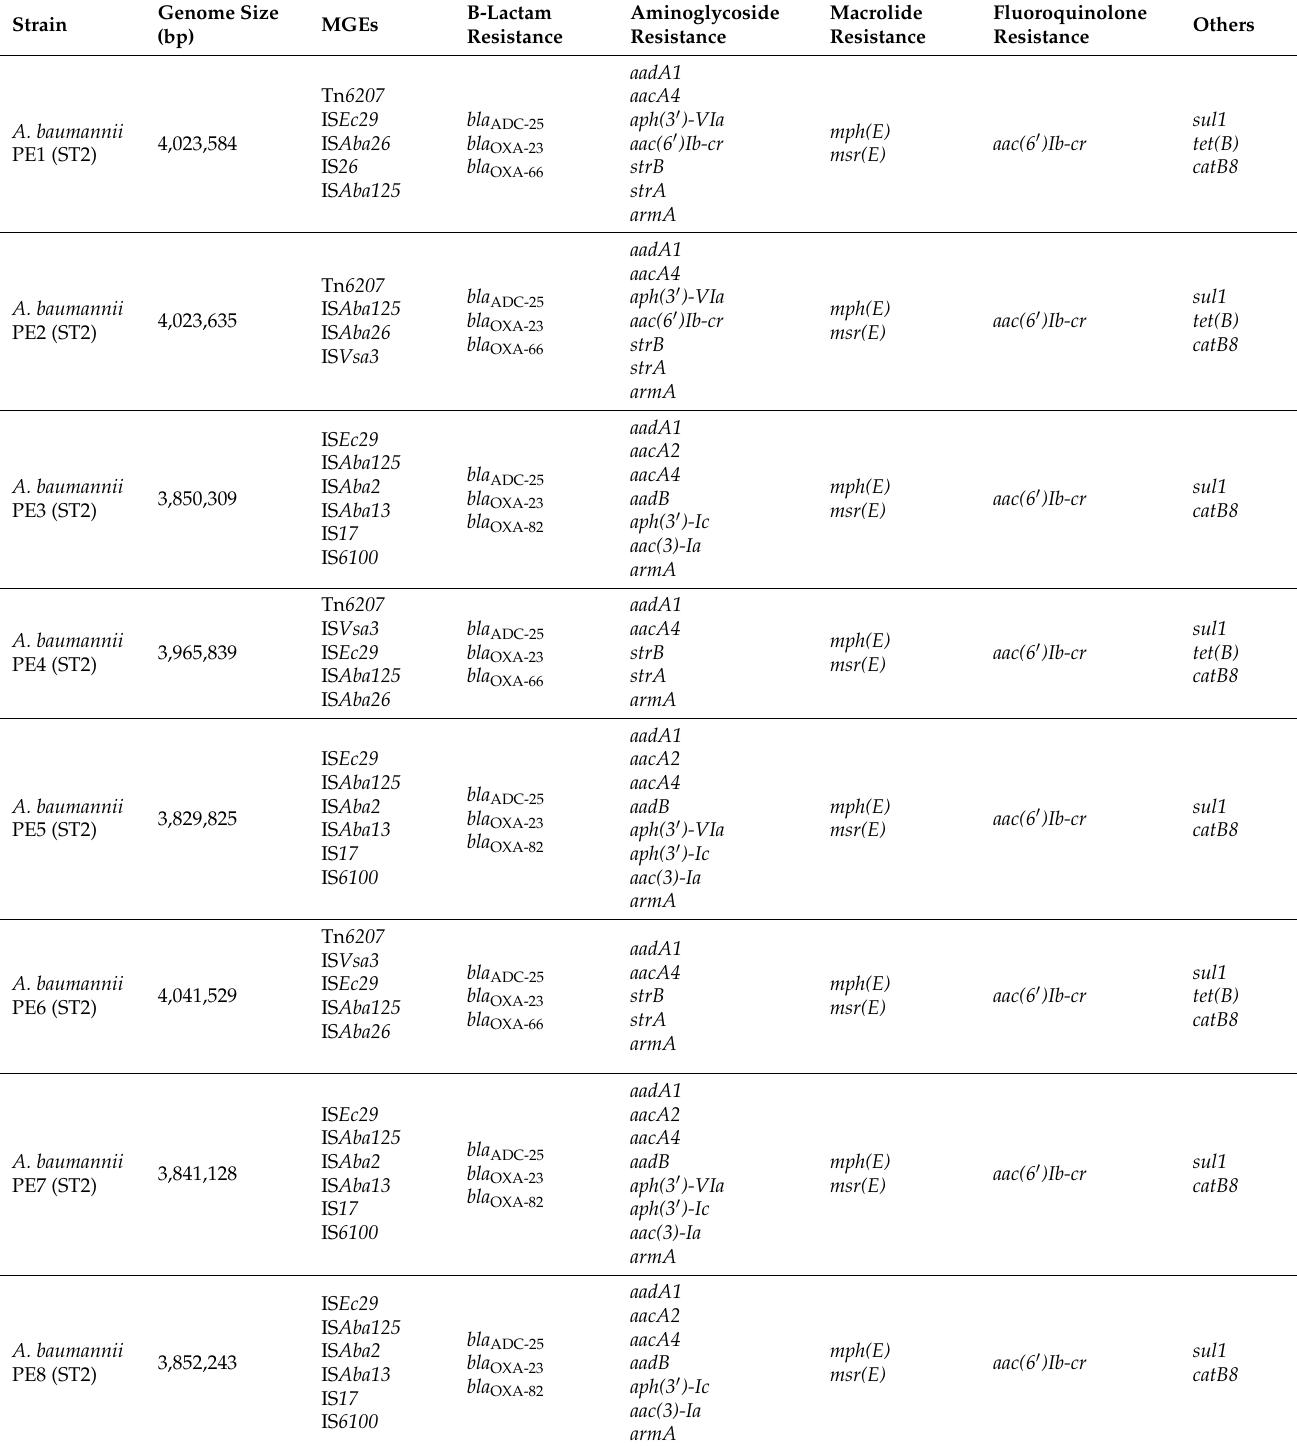
Table 1. Antimicrobial resistance genes (ARGs) and mobile genetic elements (MGEs) in bloodstream (BSI) A. baumannii